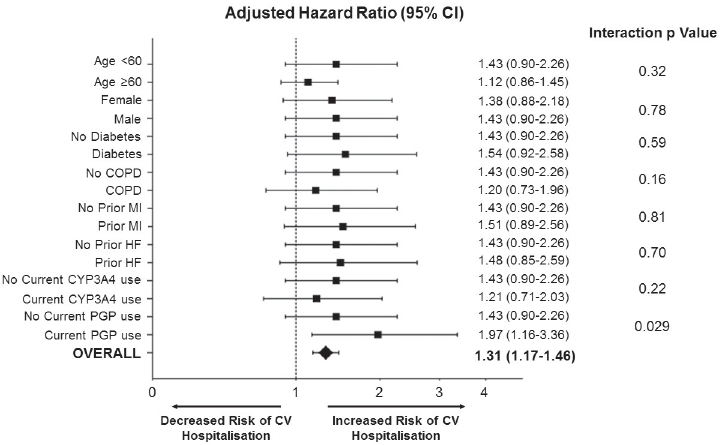
Fig 1. Subgroup analysis of risk of CV hospitalization at 14 days associated with clarithromycin use versus amoxicillin. Hazard ratio adjusted using the likelihood of clarithromycin prescription as a covariate (inverse probability of treatment weighting)—this included the following variables: age at prescription, sex, prior history of COPD, prior MI, history of type 2 diabetes, left ventricular systolic function impairment, and all medications listed in Table 1. CI, confidence interval; COPD, chronic obstructive pulmonary disease; CV, cardiovascular; CYP3A4, cytochrome P450 3A4; HF, heart failure; MI, myocardial infarction; PGP, P-glycoprotein.